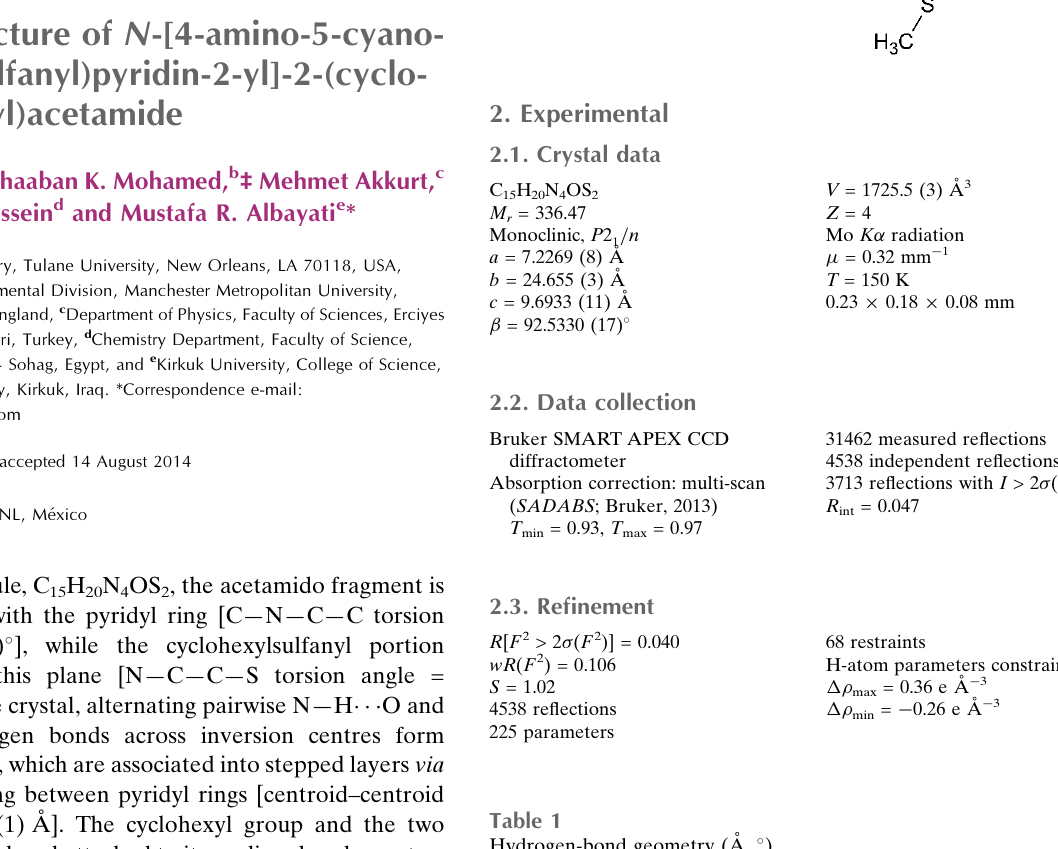
Hydrogen-bond geometry (A˚ , (cid:3)